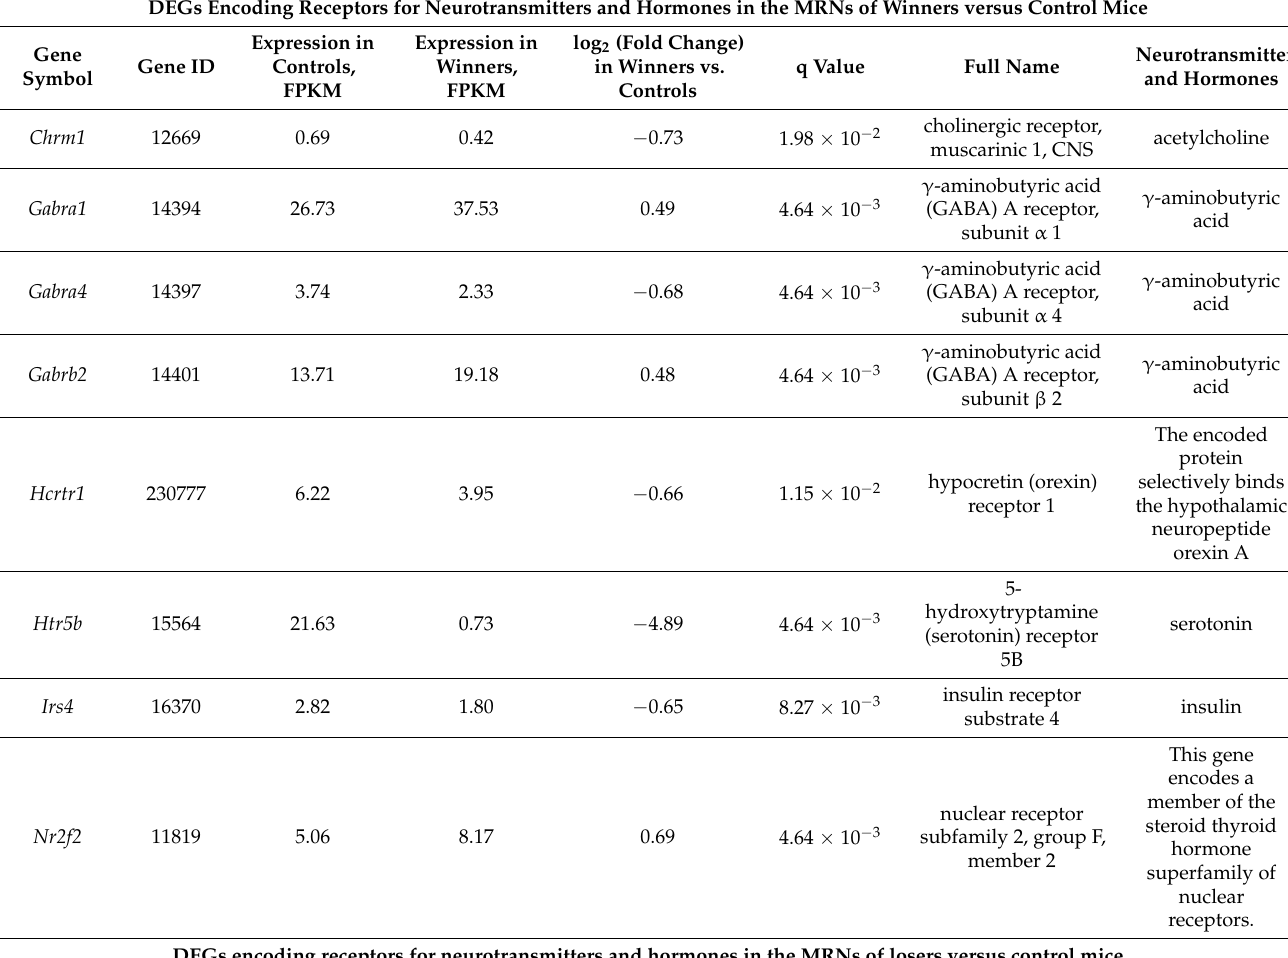
Table 4. Expression of DEGs coding for neurotransmitter and hormone